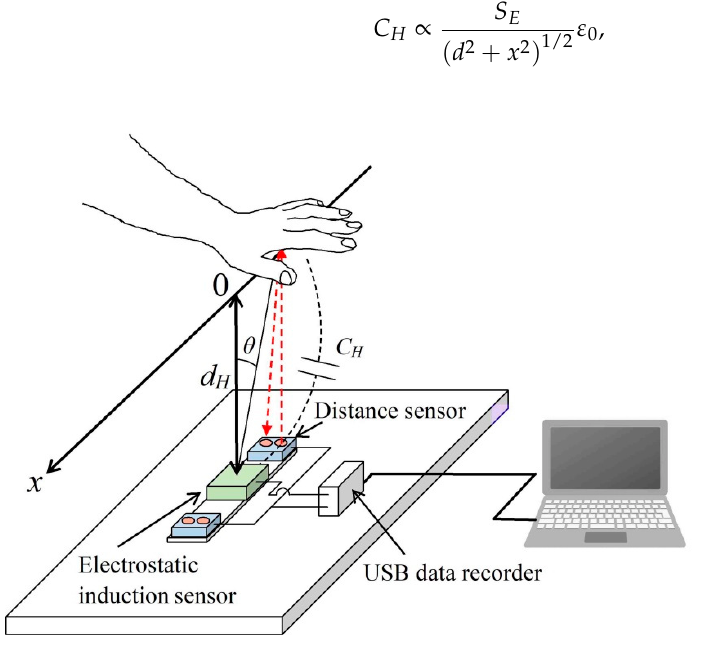
Figure 2. Schematic representation of the current electrostatically induced by palm movement.